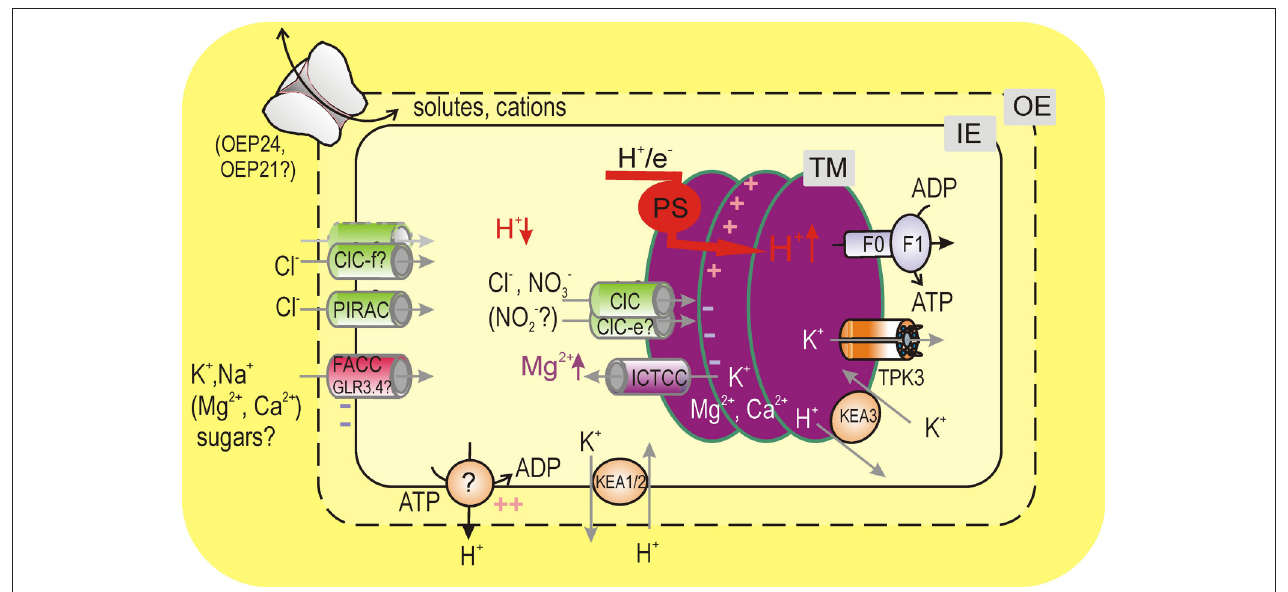
FIGURE 1 | Chloroplast ion transport under the light. Light-driven export of H + into the thylakoid lumen by photosynthetic electron transfer chain (PS) causes a hyperpolarization of the thylakoid 19 . At steady state, this voltage difference is partly dissipated by channel-mediated fluxes of anions, K + , and Mg 2 + . Light-driven H + and parallel Cl − fluxes to the thylakoid lumen cause the depletion of these ions in stroma, which is compensated by their uptake across the envelope. For maintenance of alkaline stromal pH, H + could be actively extruded to cytosol by the IE H + pump, which requires a counter influx of monovalent cations across the envelope for electrical balance. K + /H + exchange across the envelope is essential for control of the chloroplast volume and stromal pH. Abbreviations: TM, IE, and OE are thylakoid, inner envelope, and outer envelope membranes, F0F1 is thylakoid ATP-synthetase (F-type H + -ATPAse), TPK3 (tandem-pore K + 3 channel, functionally characterized in recombinant system). In situ functionally (by patch-clamp) detected channels were: ClC (anion-selective channel from a ClC family), ICTCC (intermediate-conductance thylakoid cation channel), FACC (fast activating chloroplast cation channel), PIRAC (protein import related anion channel), and outer envelope porins (most possibly, active OEP24 or OEP21). Other: GLR3.4 (glutamate receptor type 3.4 channel) and KEA1/2 (cation/proton antiporters from family 2, CPA2). Another member of the CPA2 family, the thylakoid-localized KEA3, accelerates dissipation of the transthylakoid 1 pH upon the light